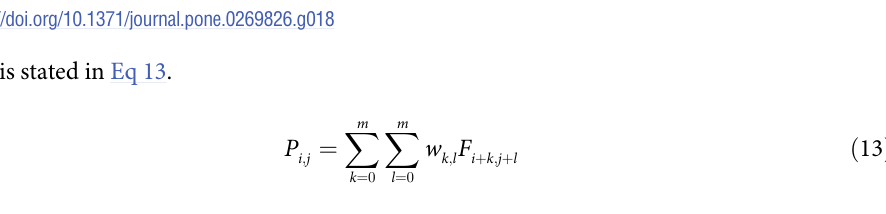
Fig 18. Resultant image after applying Box blur Table 6 represents all the selected parameter values for the algorithms associated with down-scaling process.